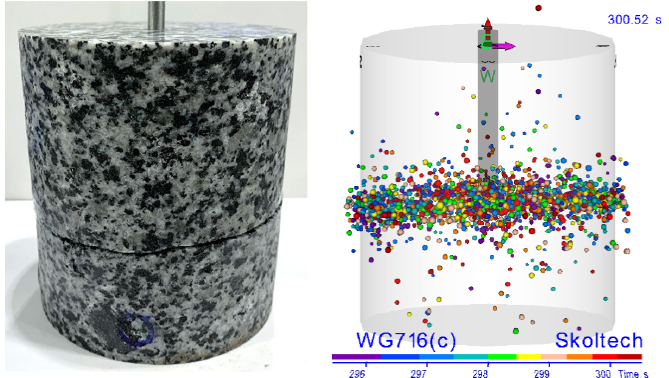
Figure 11. The specimen WG716 after the experiment ( left ) and AE event localization ( right